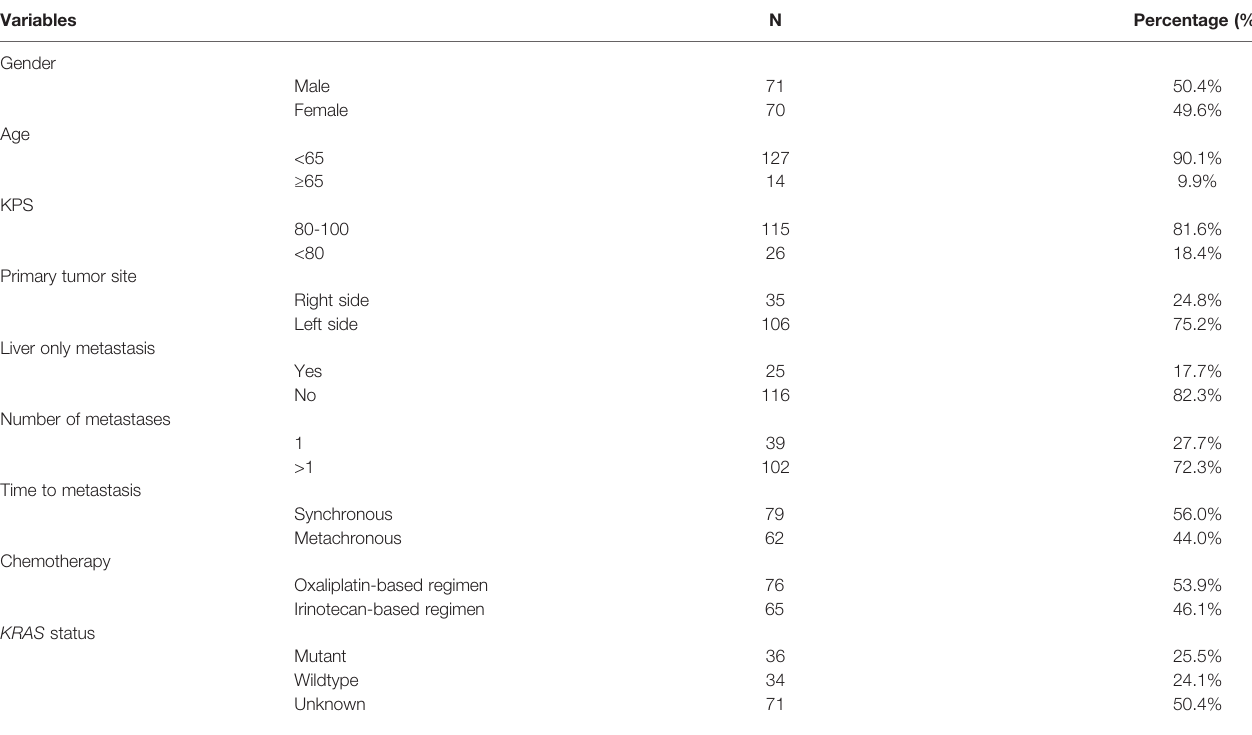
TABLE 2 | Patient characteristics